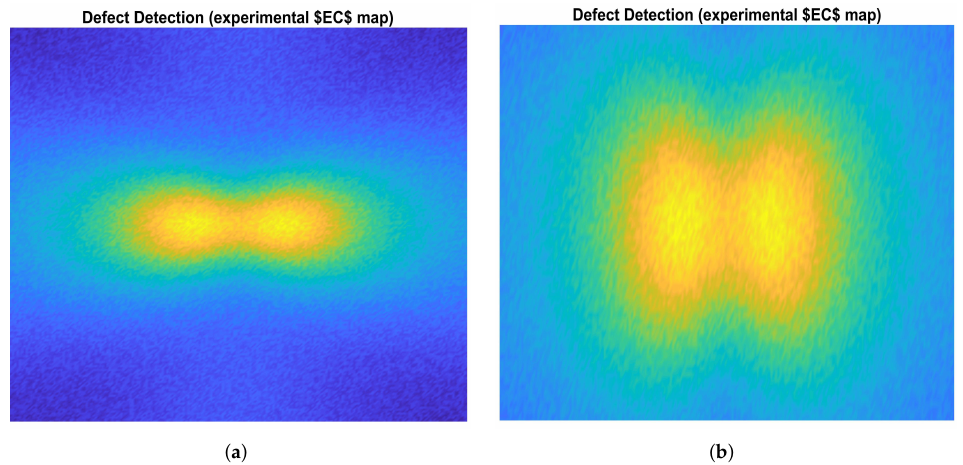
Figure 10. Reconstruction of the | B | map by experimental campain on the CFRP plate area with ( a ) a defect of radius R = 0.1 mm and ( b ) a defect of radius R = 0.6